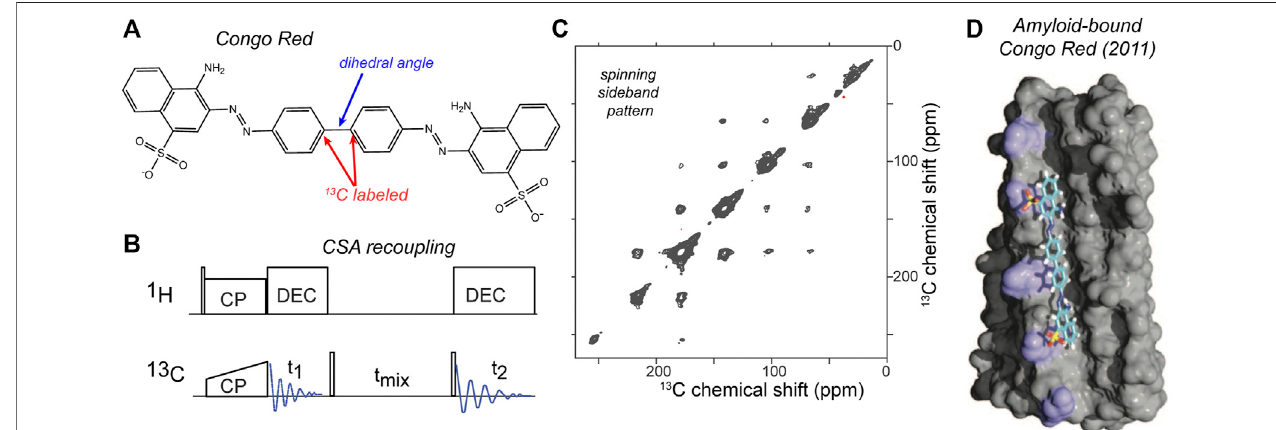
FIGURE 8 | CSA-recoupling with selective labeling: amyloid dye Congo Red. (A) Chemical structure of congo red, which is widely used to detect amyloid structures. For the CSA recoupling experiments the 1 and 1 ′ carbons are 13 C labelled (marked red), in order to measure the marked dihedral angle (blue). (B) Pulse sequenceusedfortheCSArecouplingexperimentusedby(Gowdaetal.,2017)tomeasurethedihedralanglemarkedin (A) . (C) 2D 13 C- 13 Ctensorcorrelationspectrum at8 kHzMASona850-MHz( 1 H)spectrometer,usingtheindicatedpulsesequencewitha50-msrotor-synchronized 13 C- 13 Ctransfertime.Thesamplecontained HET-s amyloid fi brils withthe selectively labeled congored bound. Formore detailssee ref.(Gowda et al.,2017). (D) Structural model ofamyloid-bound congored from prior ssNMR studies by the same groups, adapted with permission from ref. (Schütz et al., 2011).